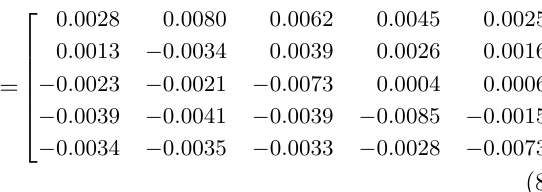
is practically optimal. Looking at the plots of singu- lar values displayed in Fig. 10, we can appreciate that the graphic corresponding to the velocity-feedback con- troller in eq. (91) presents a small peak around the sec- ond resonant frequency (2.8246 Hz). For all the other frequencies, the proposed velocity-feedback controller feedback controller in eq.